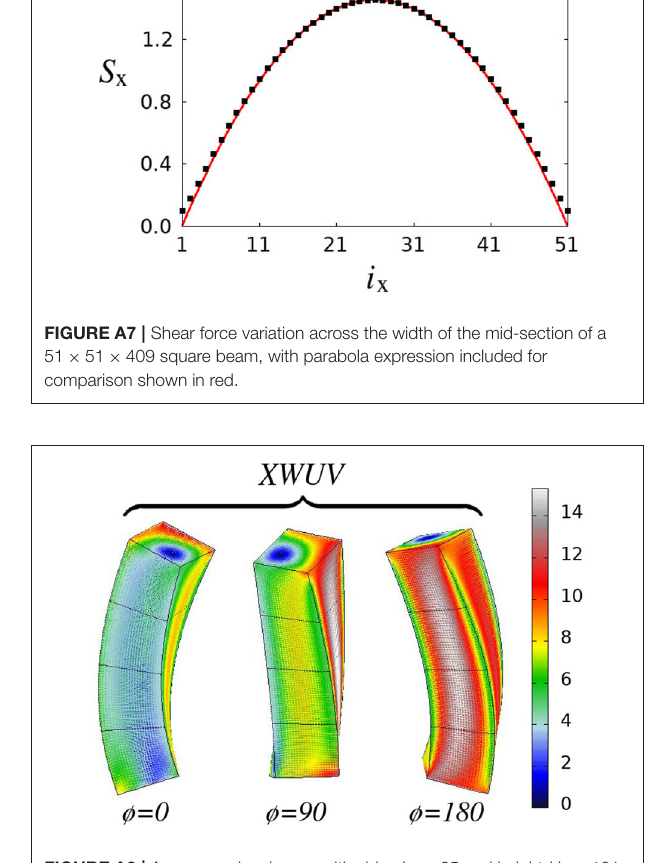
Table A1 obtained for the average forces on the sides where shear increases or decreases compare favorably with values expected